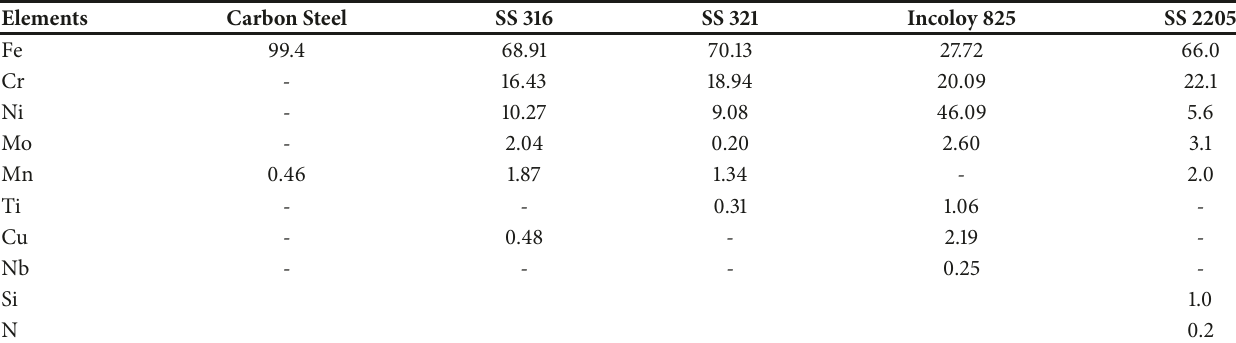
Table 1: Chemical compositions of the alloys (in Wt